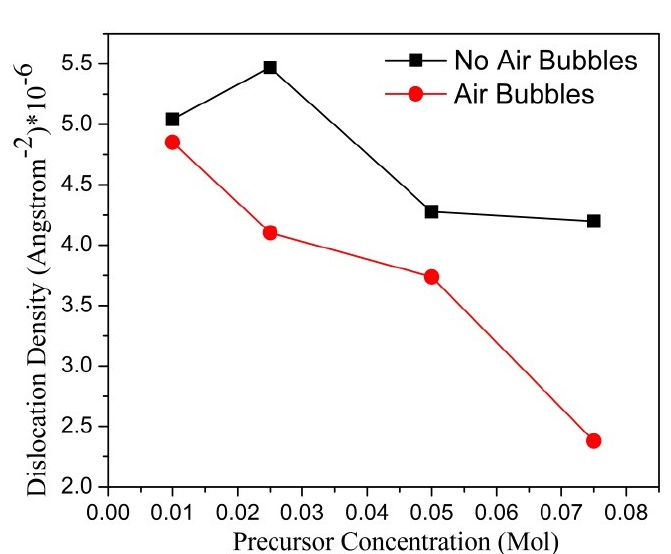
Figure 9. Variation of dislocation density at several precursor concentrations for both preparation methods, conventional and modified CBD, respectively.